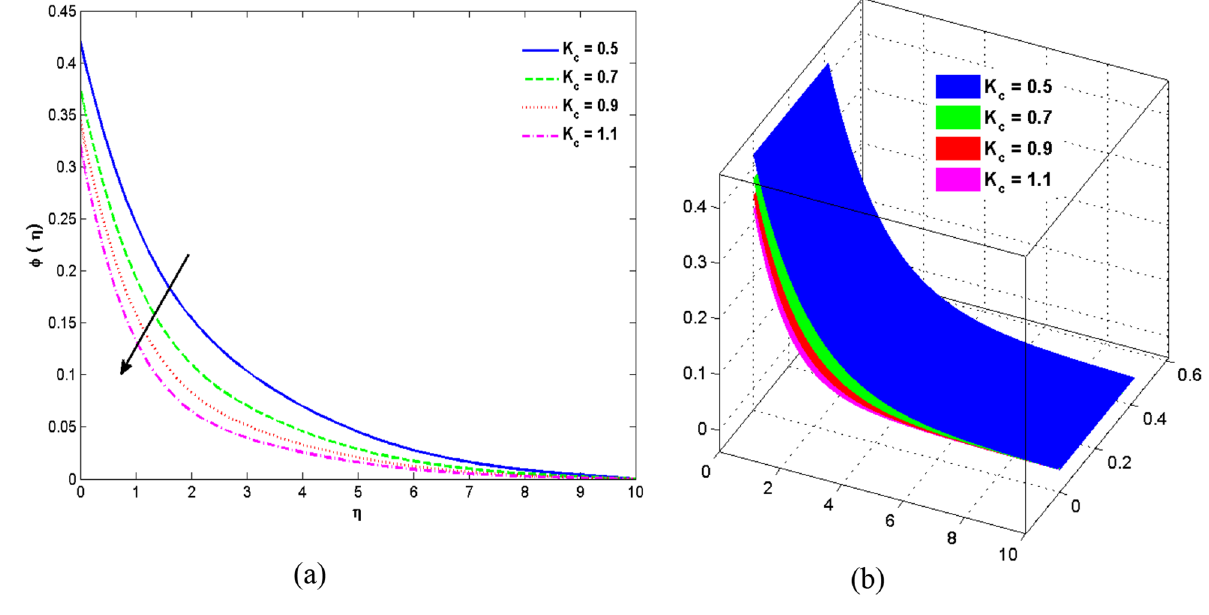
Figure 11. Variations of K c to φ(η) .